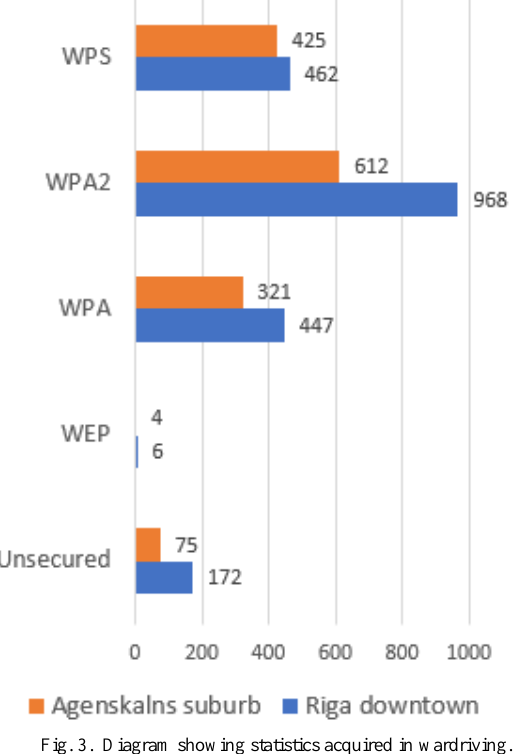
Fig. 3. Diagram showing statistics acquired in